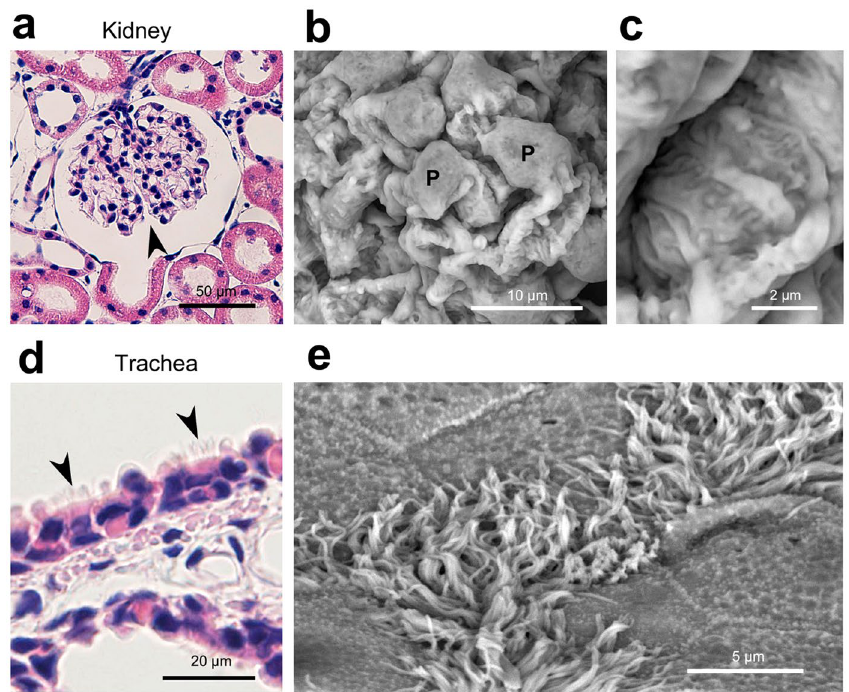
Figure 4. Representative micrographs of rat kidney and trachea. Electron micrographs were taken from 30 µ m sections. ( a – c ) Kidney. ( a ) Overview of the glomerulus (arrowhead) within the renal corpuscle. ( b ) Podocytes (P) covering the glomerular capillaries. ( c ) High-power view demonstrates the engaged processes. ( d , e ) Trachea. Note the ciliated epithelial cells (arrowheads) distinguished by Thick